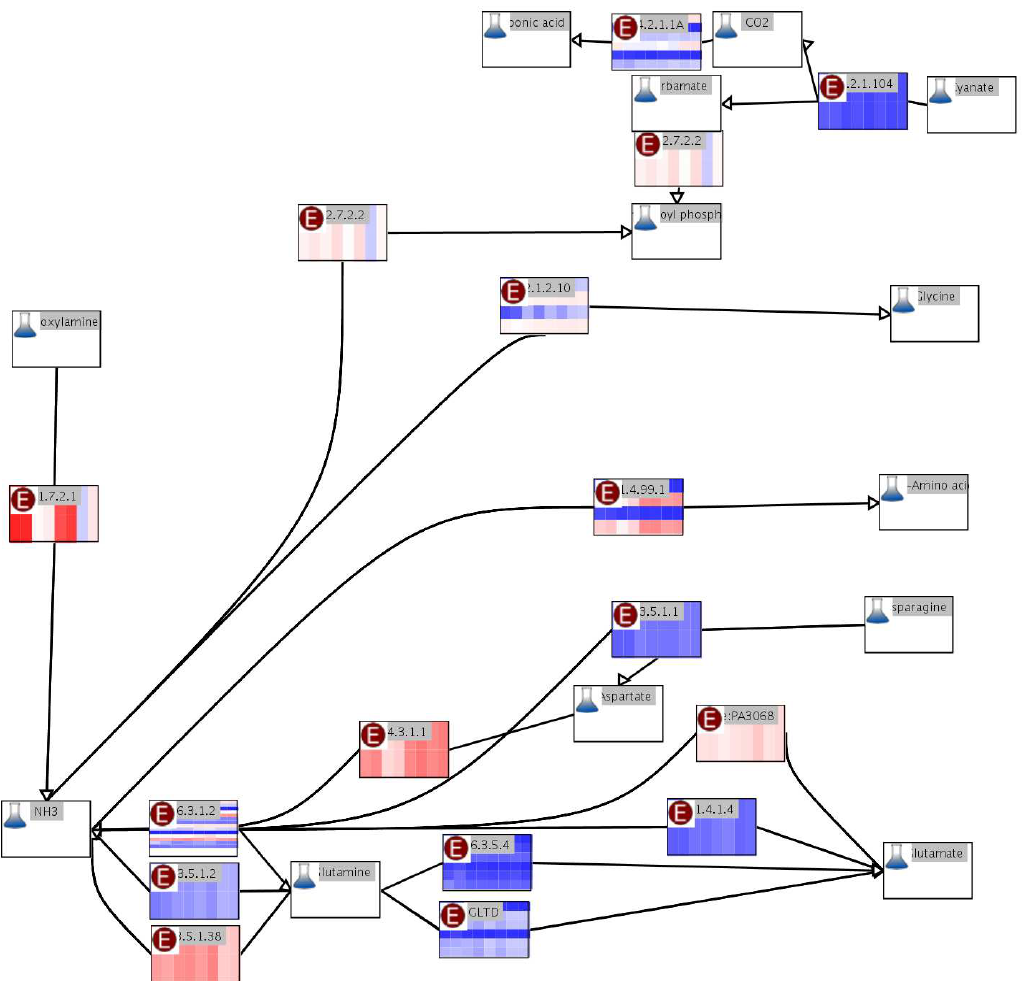
Figure 2: Amino acid-related part of the nitrogen metabolism of Pseudomonas aeruginosa (KEGG pathway id pae00910). All probes associated with the relevant enzymes are shown, either as pro- files or as heatmap rows. Expression values are encoded as colors (low=blue, high=red) and as pro- files. Conditions are ordered ascendingly by oxygen concentration (anaerobic, 0.4%, 2%, 20%), with both replicates per condition shown as seperate adjacent experiments. Enzymes are marked with the letter “E”, metabolites are marked with the image of an Erlenmeyer flask. Components are labelled with names assigned by